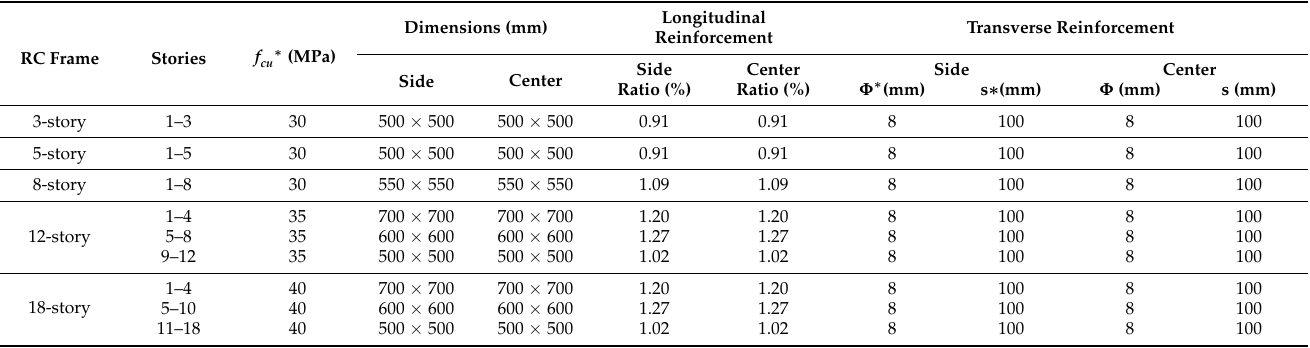
Table 5. The properties of the